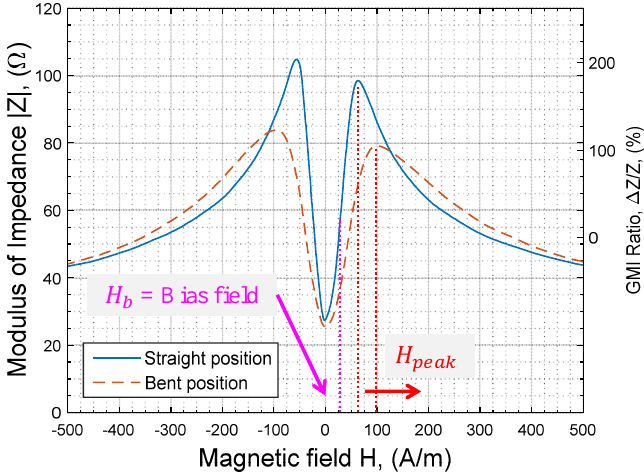
Figure 3. Change of | Z ( H ) | and ∆ Z / Z with the bending stress.